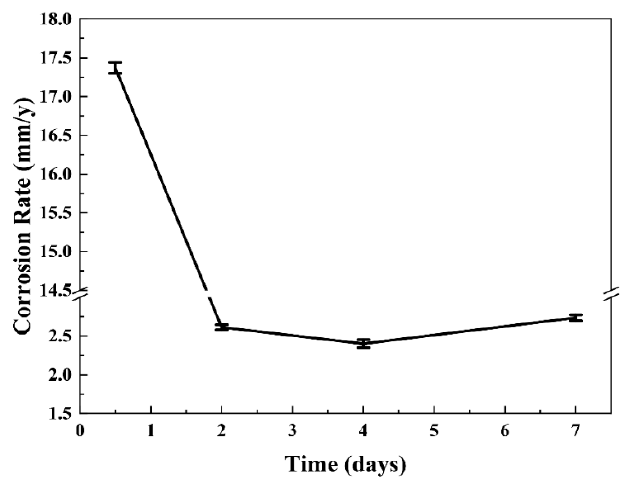
Figure 3. Corrosion rate of L245N standard steel in simulated solution after different times.